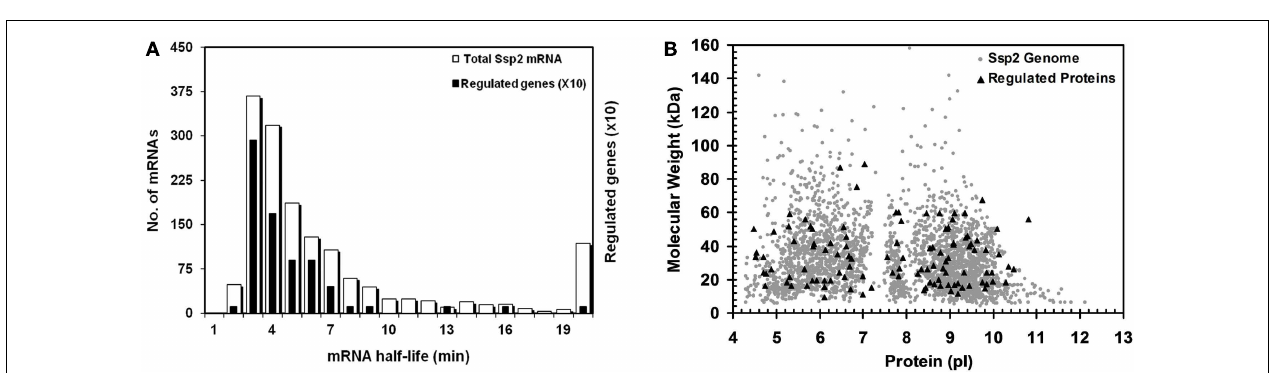
FIGURE 3 | Comparison of phosphorylated and total proteome of S. solfataricus (P2). 2D-gels at 36h post-infection. (A) Proteome staining with the fluorescent dye Sypro Ruby. (B) Same gel using the phosphoprotein